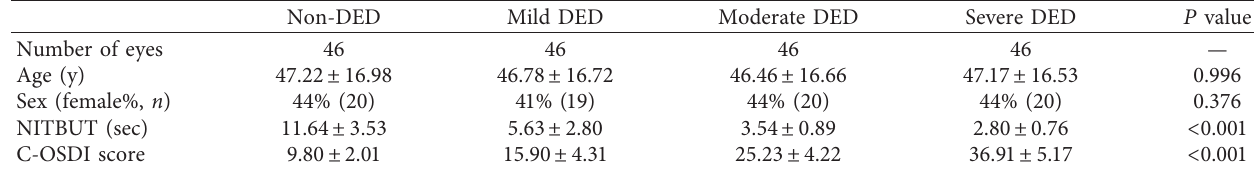
Table 1: Demographic characteristics of participants in the study.